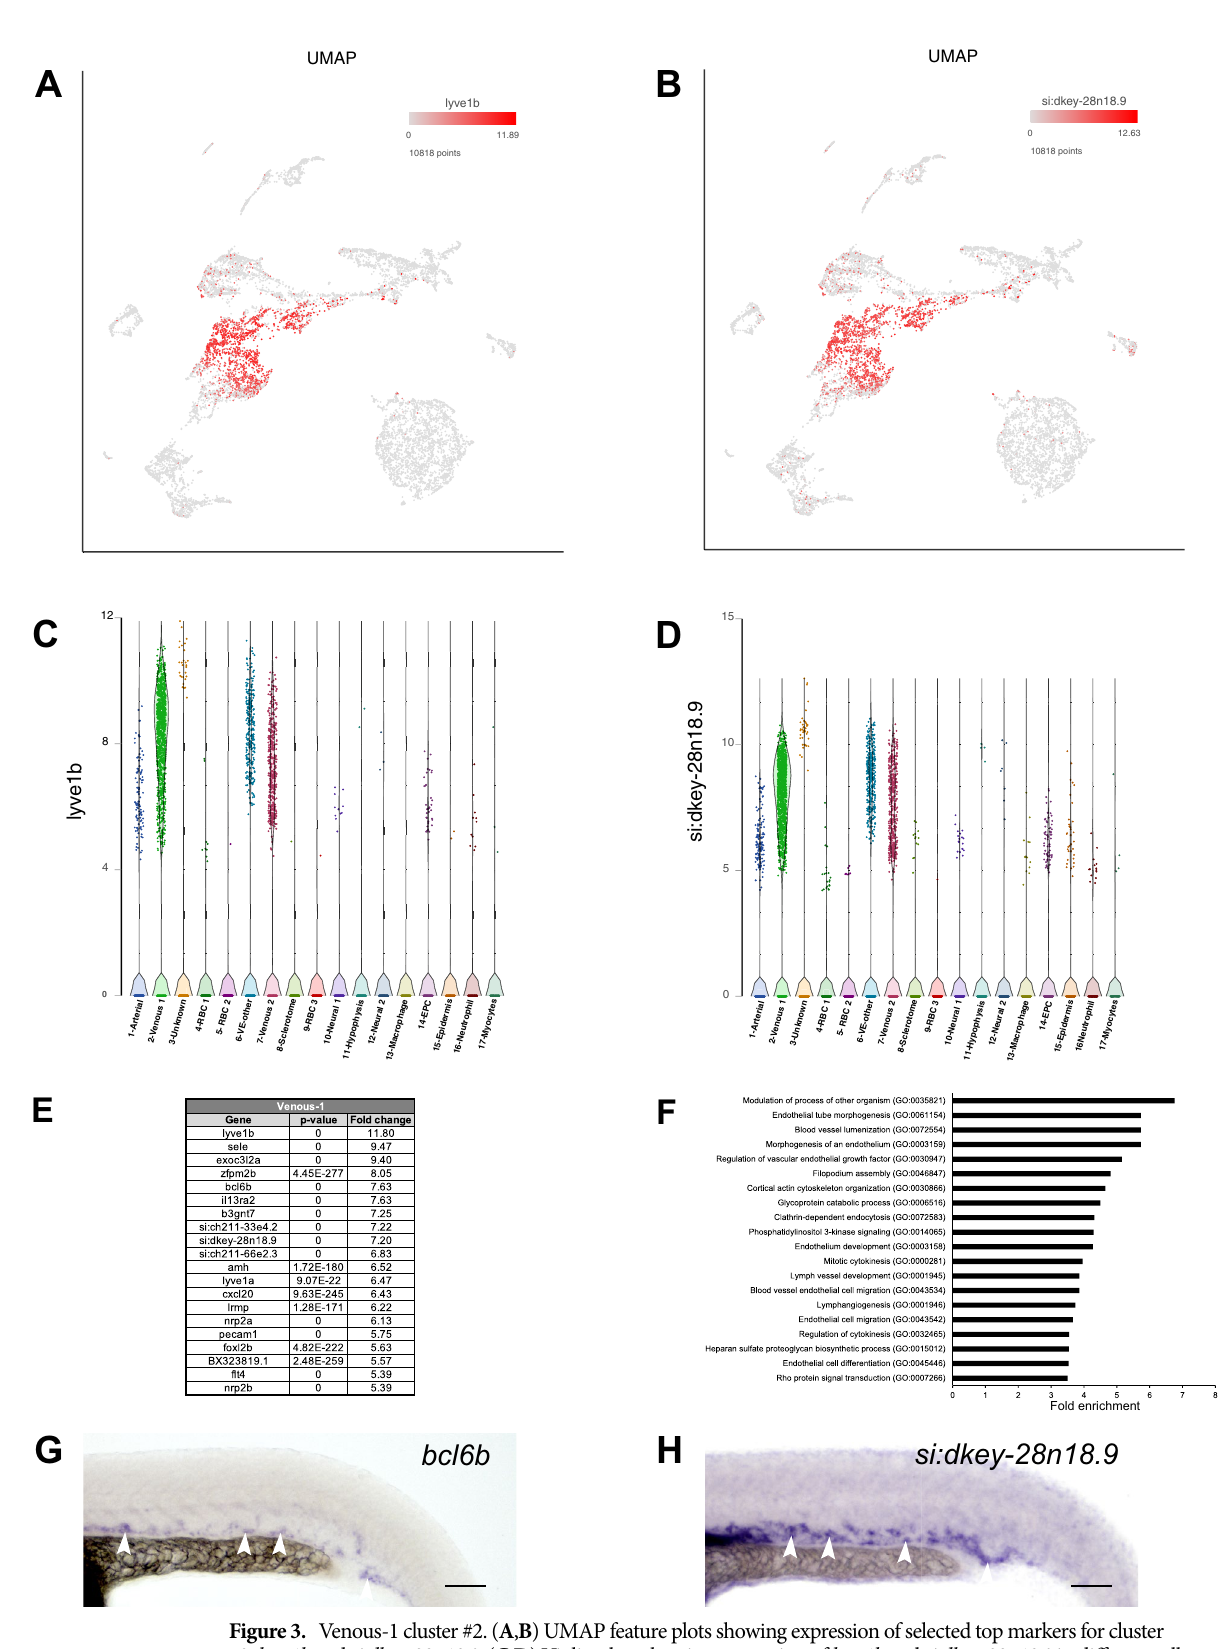
Figure 3. Venous-1 cluster #2. ( A , B ) UMAP feature plots showing expression of selected top markers for cluster #2, lyve1b and si:dkey-28n18.9 . ( C , D ) Violin plots showing expression of lyve1b and si:dkey-28n18.9 in different cell populations. ( E ) List of top 20 marker genes differentially expressed in Venous-1 cluster. ( F ) List of top 20 pathways enriched in Venous-1 cluster. ( G , H ) In situ hybridization analysis at 24 hpf for previously uncharacterized genes bcl6b and si:dkey-28n18.9 . Note the expression of bcl6b and si:dkey-28n18.9 in the posterior cardinal vein (arrowheads). Scale bars: 100